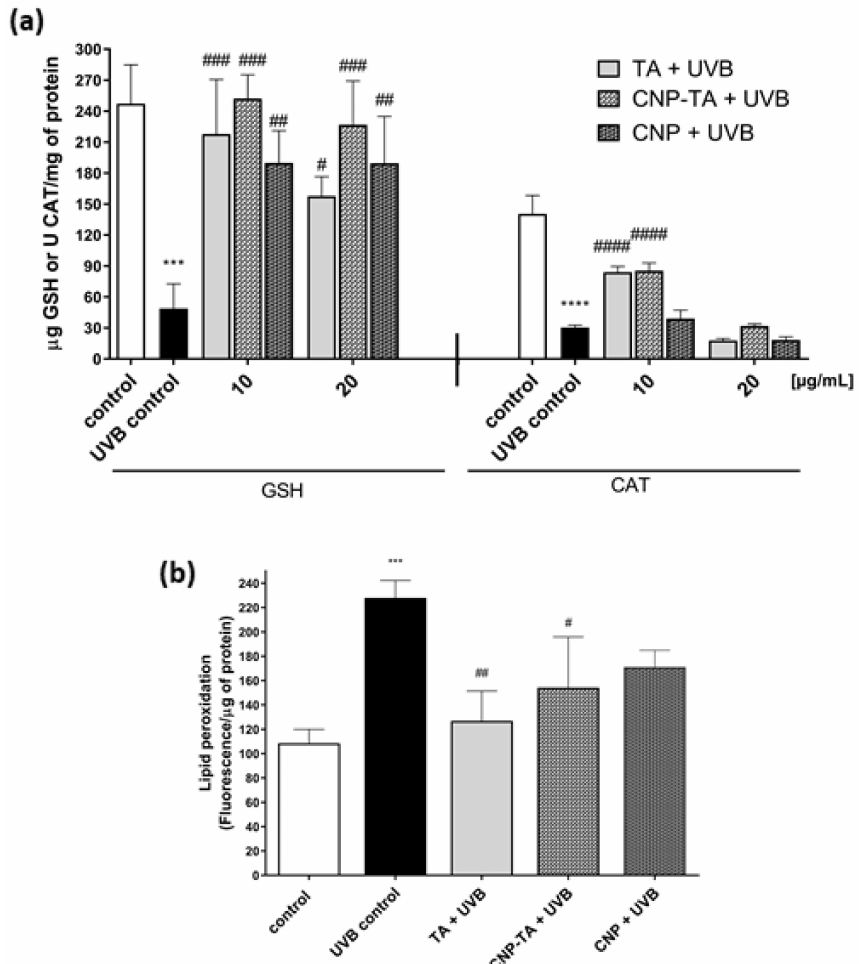
Figure 5. ( a ) Effect of TA, CNP-TA and CNPs on the restoration of reduced glutathione (GSH) and catalase enzyme (CAT) in L-929 fibroblasts treated (10 and 20 µ g/mL) and irradiated with UVB. ( b ) Effect of TA, CNP-TA and CNPs against lipid peroxidation in L-929 fibroblasts treated (10 µ g/mL) and irradiated with UVB. After 24 h of incubation, lipid peroxidation was measured using the DPPP marker. Control: non-irradiated and untreated cells; UVB control: irradiated and untreated cells. *** p < 0.001 and **** p < 0.0001 compared to the control, # p < 0.05, ## p < 0.01, ### p < 0.001 and #### p < 0.0001 compared to UVB